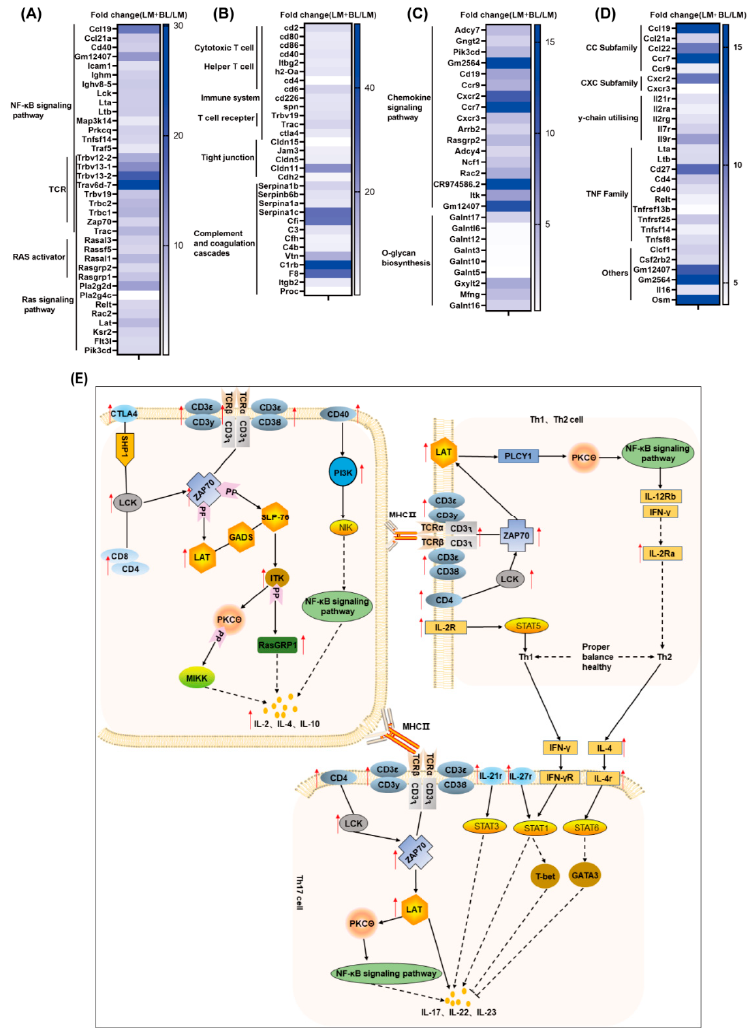
Figure 7. Transcriptomics revealed that baicalin regulates intestinal immunity and repairs intestinal damage. Fold change of differentially expressed genes related to ( A ) NF- κ B signaling pathway and ras signaling pathway; ( B ) intestinal immunity cell adhesion molecules and complement and coag- ulation cascades; ( C ) chemokine signaling pathway and O-glycan biosynthesis; ( D ) cytokine–cyto- kine receptor interaction as well as T-cell receptor signaling pathway; and ( E ) the process of Th1/Th2 and Th17 cell differentiation. The red arrows indicate upregulation.